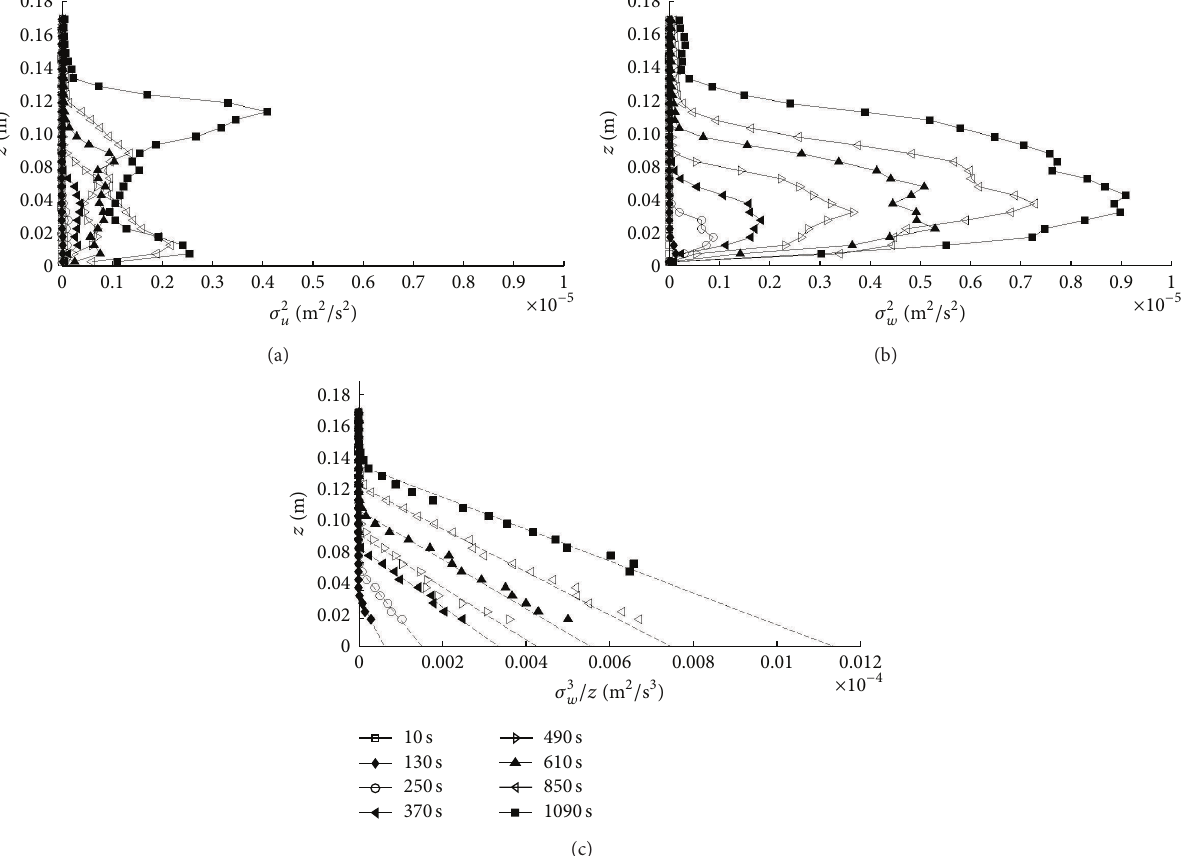
Figure 8: Time evolution of (a) the horizontal velocity variance profiles; (b) the vertical velocity variance profiles; (c) 𝜎 3 𝑤 /𝑧 profiles for experiment